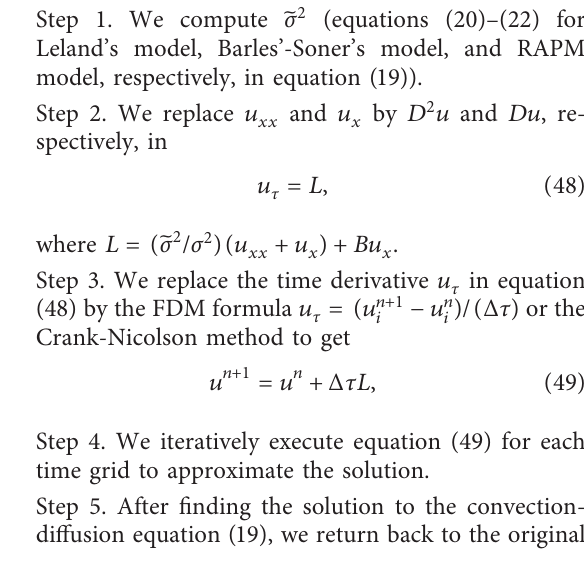
Algorithm 1. The nonlinear BS